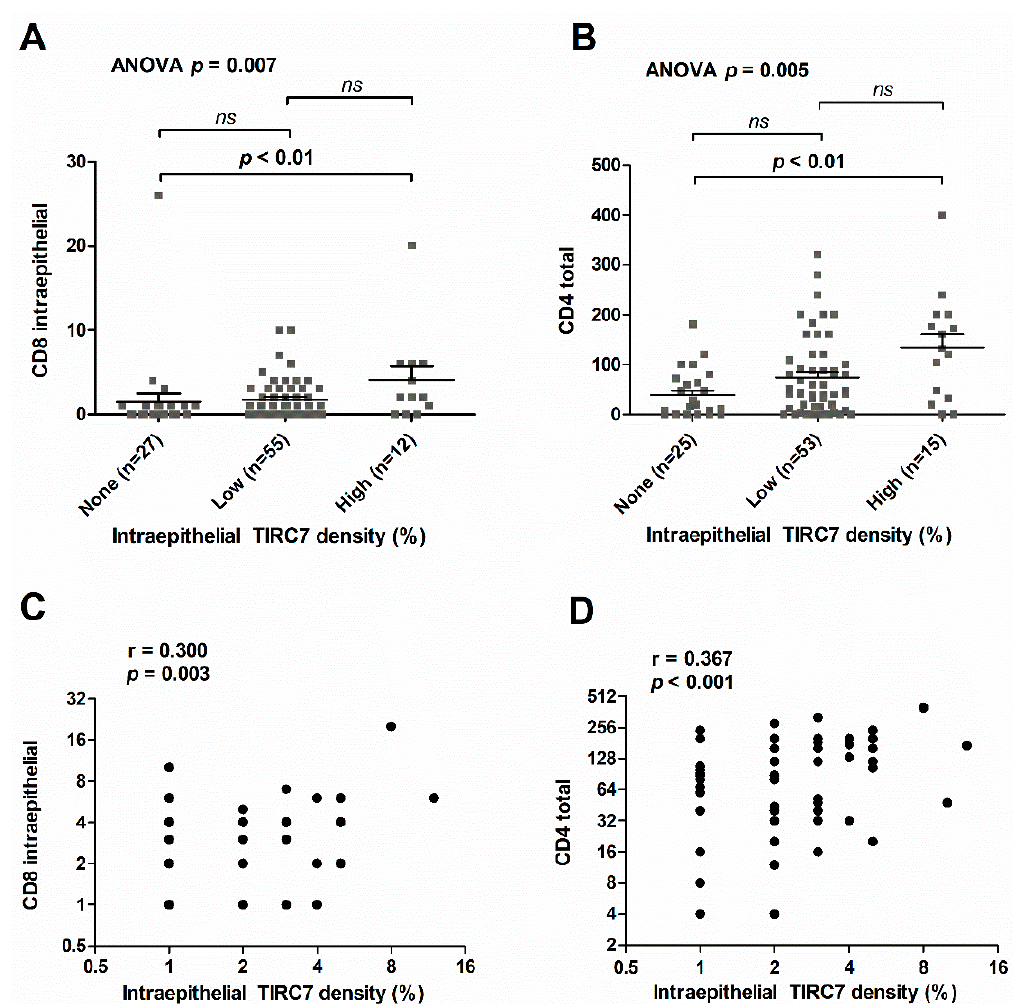
Figure 5. Association of intraepithelial TIRC7 + immune cell density with immune cell phenotype. Analysis of quantity of intraepithelial CD8 + ( A ) or total CD4 + ( B ) T cells in CCA cases with absent (0%), low (1–3%) or high ( ≥ 4%) intraepithelial TIRC7 + immune cell density shown by scatter dot plots with mean and SEM (CD8 Kruskal–Wallis p = 0.007; CD4 Kruskal– Wallis p = 0.005). Correlation of intraepithelial CD8 + ( C ) or total CD4 + ( D ) T cells with intraepithelial TIRC7 + immune cell density, as indicated (CD8 Spearman r = 0.300, p = 0.003; CD4 Spearman r = 0.367, p < 0.001). Overall group comparison was performed using the Kruskal–Wallis followed by Dunn’s test for post hoc pairwise comparisons ( A , B ). Correlation metrics were computed out using Spearman’s correlation analysis ( C , D ). Table 2. Association of intraepithelial TIRC7+ immune cell density with immune cell composition.